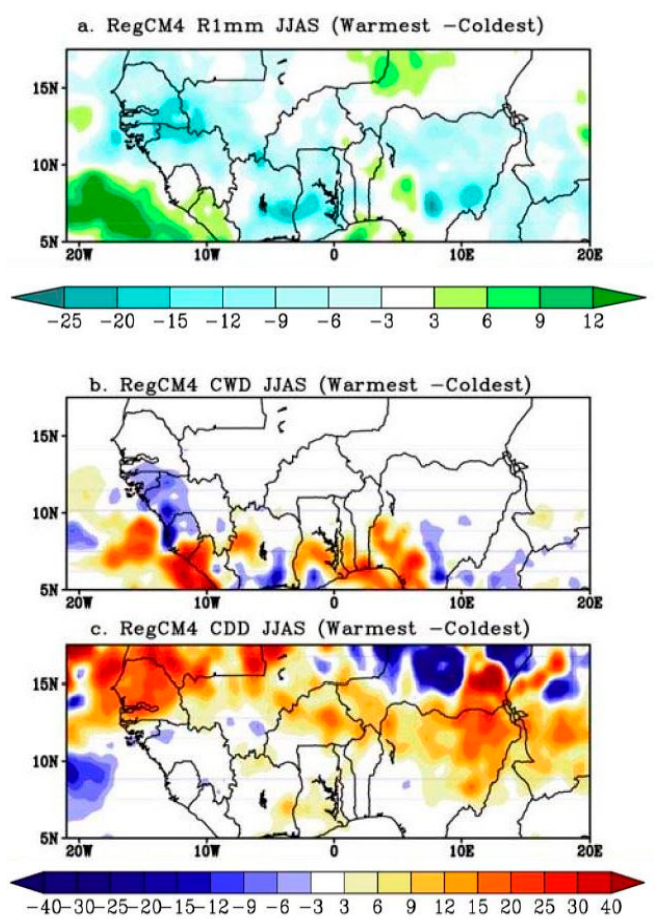
Figure 6. Climate indices over West Africa from RegCM4 model: (average of the warmest years—average of the coldest years) for JJAS mean; ( a ) the number of rainy days (R1mm), ( b ) the consecutive wet days (CWD), and ( c ) the consecutive dry days (CDD).